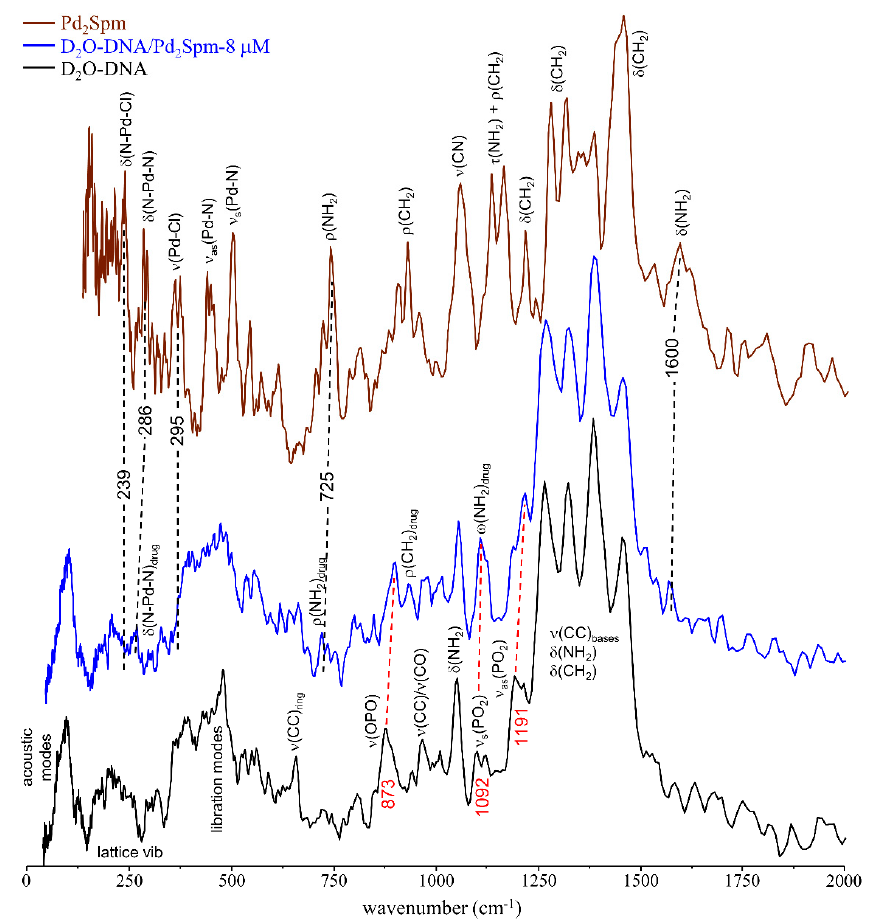
Figure 5. INS spectra (at 10 K) of D 2 O-DNA hyd untreated and upon incubation (for 48 h) with Pd 2 Spm-8 µ M. The spectrum of the free drug is also shown [17]. (The main drug-triggered vibrational changes are shown by red and black dashed lines and wavenumbers for DNA’s and Pd 2 Spm vibrational modes, respectively).